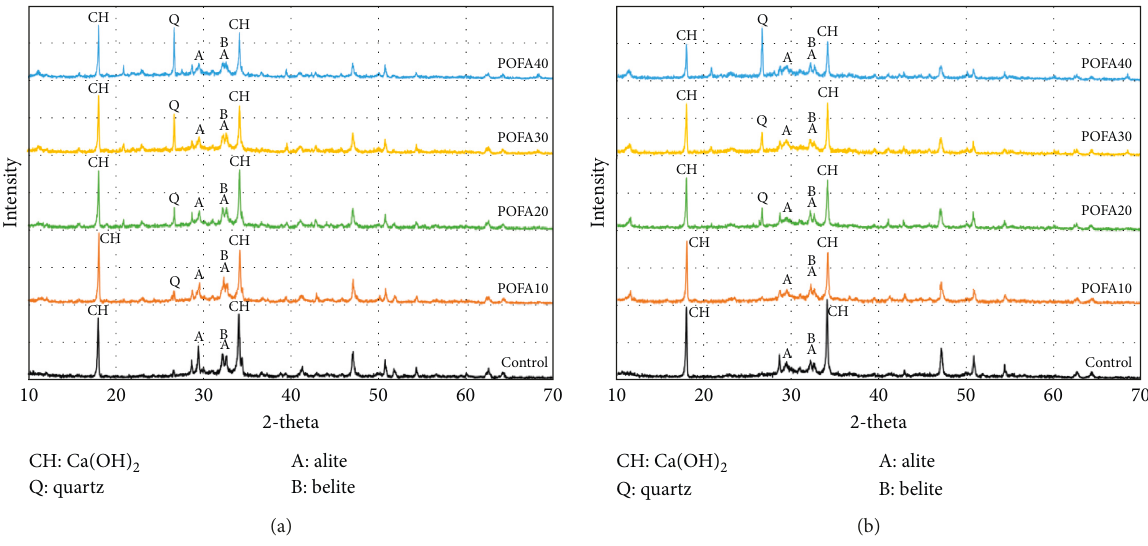
Figure 9: XRD patterns of pastes containing mPOFA aged for (a) 3 and (b) 28